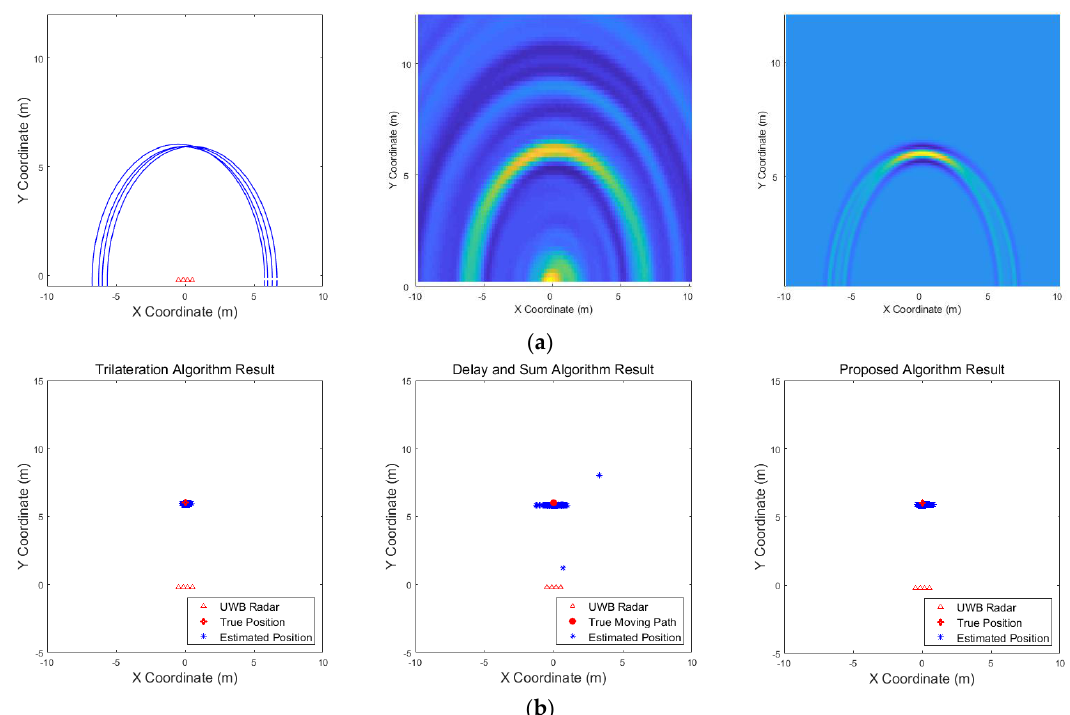
Figure 21. Experimental results when one target stands 6 m from the wall (Scenario 1): ( a ) instantaneous results of position estimation step according to the positioning algorithm; ( b ) results of the through-wall radar system